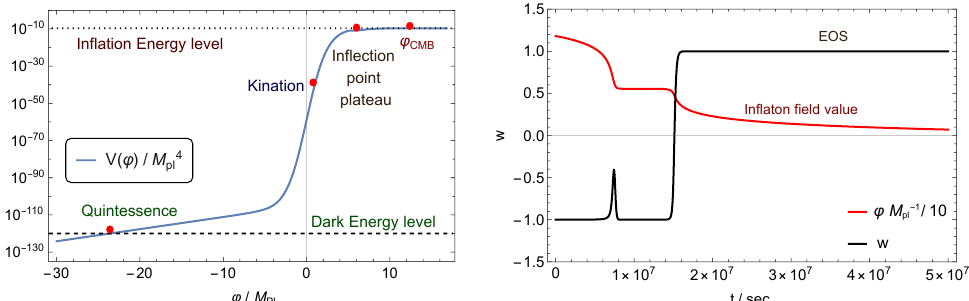
Figure 9. In the left panel the unified inflaton-quintessence potential is shown in logarithmic scale. The critical stages of reheating, the PBH production and evaporation are highlighted. In the right panel the equation of state (EOS) parameter and the inflaton field value are depicted making manifest the the presence of an infection point plateau and the postinflationary runaway phase.